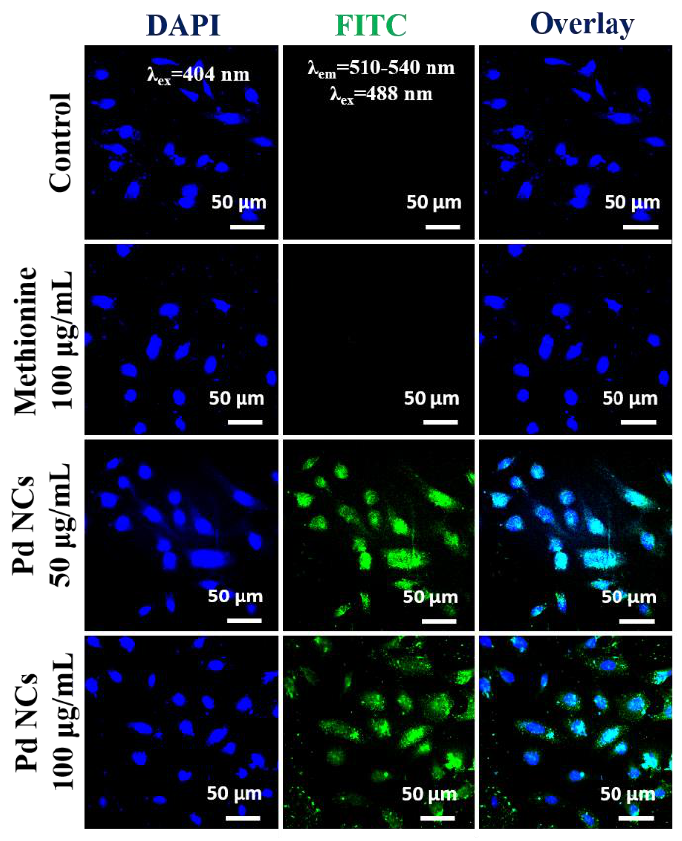
Figure 6 . In vitro cell labeling properties of Pd NCs. HeLa cells were treated with various concentrations of Pd NCs and DL-Methionine. Blue fluorescence represents the nucleus which was stained with DAPI and green fluorescence originating from Pd NCs.